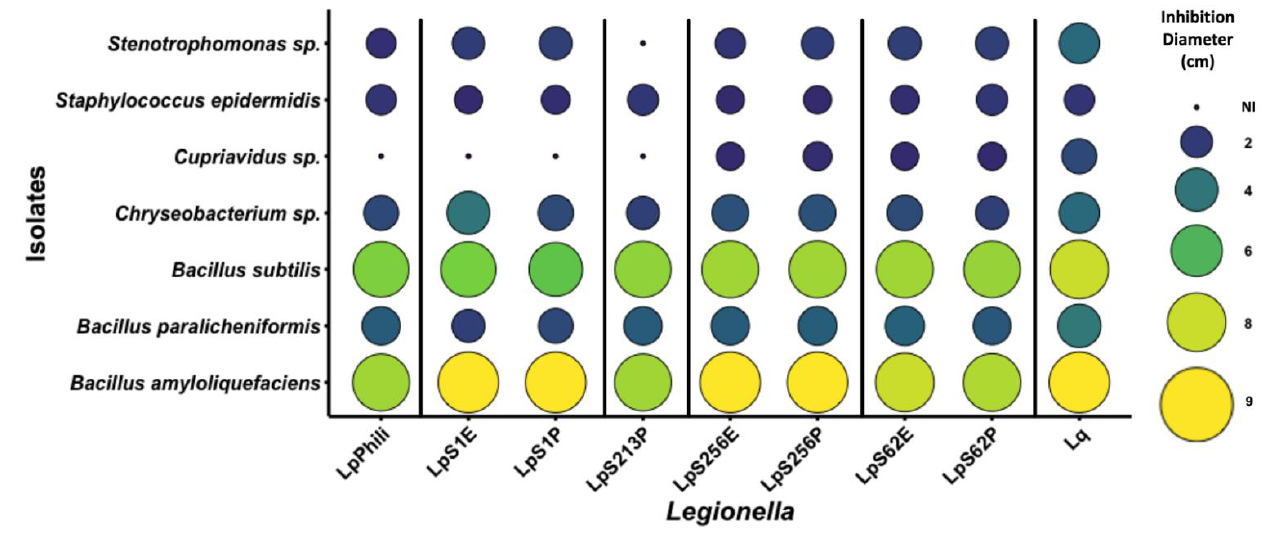
Figure 2. Inhibition zone diameters, in centimeter, produced by bacterial isolates on lawns of differ- ent strains of Legionella grown on CYE agar incubated at 30 °C for 4 days. The inhibition zone diam- eter is indicated by the size of the circle and by colour scale (from purple to yellow; NI: no inhibi- tion).